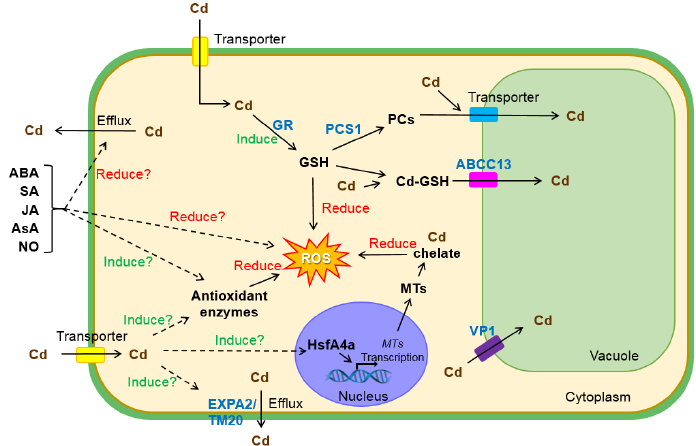
Figure 1. A diagram explaining the molecular mechanisms of cadmium (Cd) resistance in wheat. ABA, abscisic acid; SA, salicylic acid; JA, jasmonic acid; AsA, ascorbic acid; NO, nitric oxide. ROS, reactive oxygen species; GR, glutathione reductase; GSH, reduced glutathione; PCs, phytochelatins; PCS1, PC synthase 1; MTs, metallothioneins. ABCC13, ATP binding cassette subfamily C member